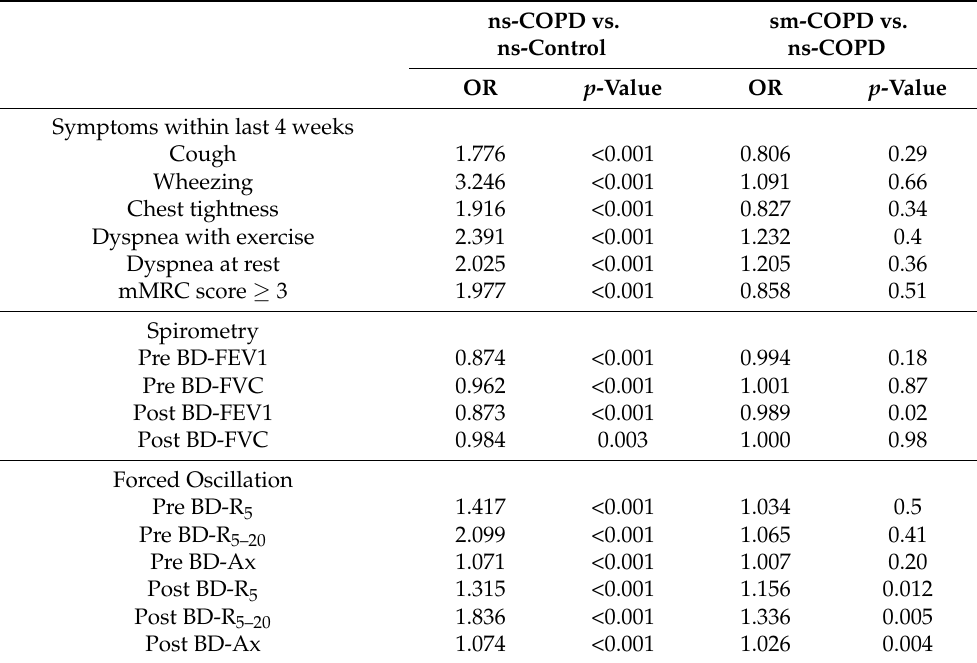
Table 3. Symptoms, spirometry, and oscillometry adjusted by age, gender, and race using logistic regression models.